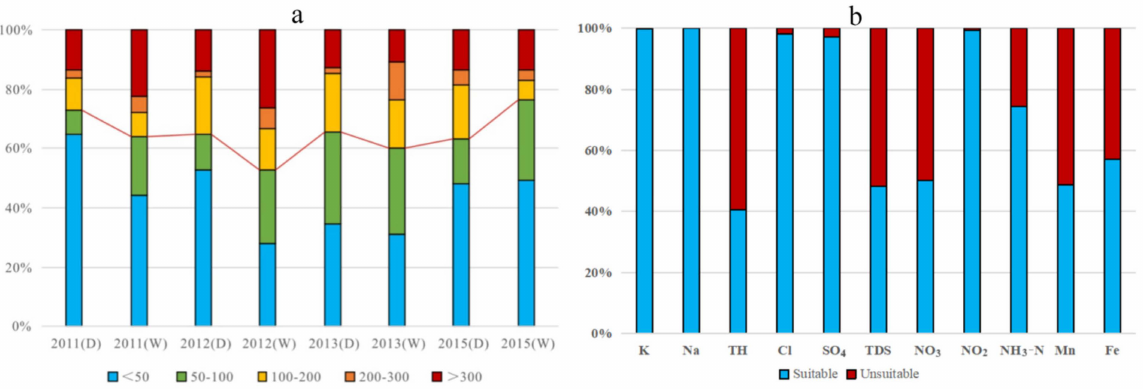
Figure 4. Grades histogram of groundwater samples for drinking purposes in seasons ( a ) and parameters ( b